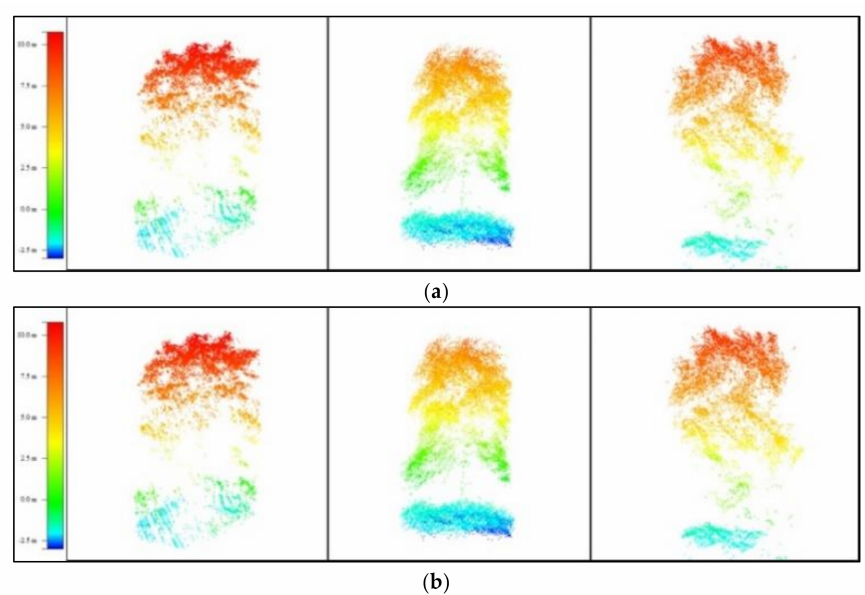
Figure 4. The results of the segmentation of the individual tree point clouds from ( a ) LiDAR data acquisition and ( b ) photogrammetry data